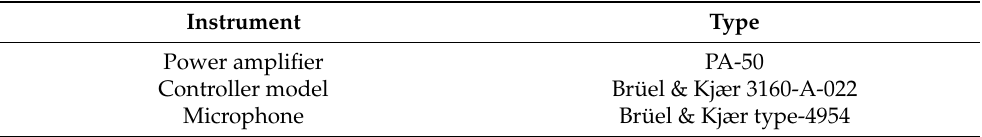
Figure 6. ( a ) Experimental set-up. Sample photograph was placed in the middle region of the waveguide. We measured and simulated transmittance spectra through the sample in a waveguide for the ( b ) left and ( c ) right incidences of plane sound waves. Table 3. Types of instruments.